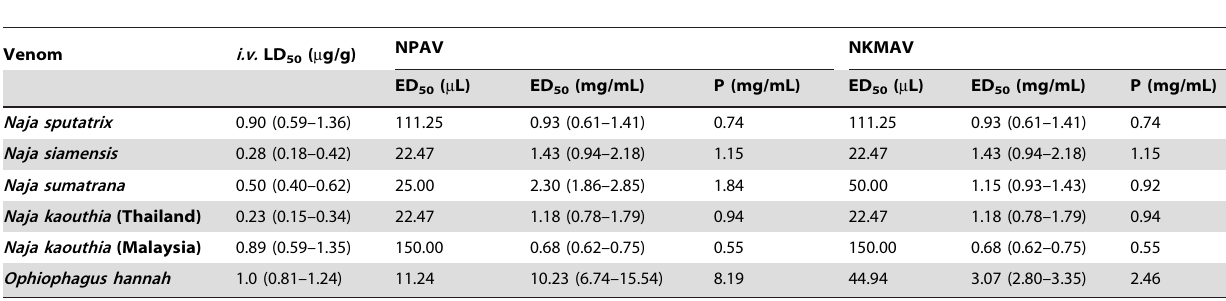
Table 2. In vitro and in vivo neutralization of cobra and krait venoms by NPAV and NKMAV.